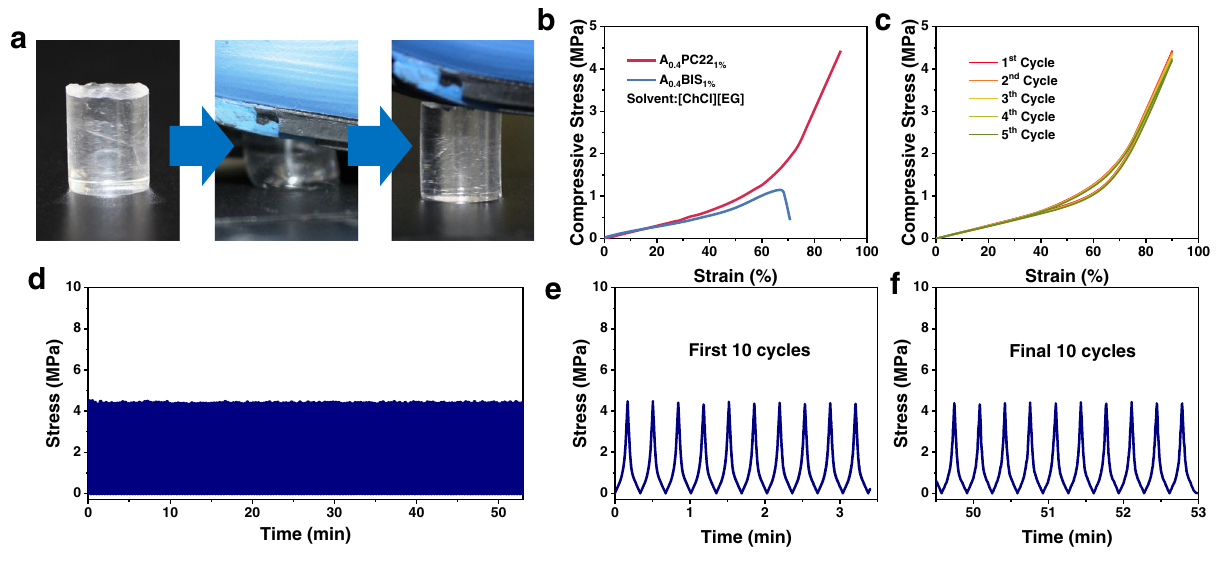
Fig. 4 | Compression mechanical properties of the eutectogels with [ChCl][EG] as solvent. a No damage occurred after stepping strengthly on a gel. b Compressive stress-strain curves of gels crosslinked with PC22 and BIS. c Stress-